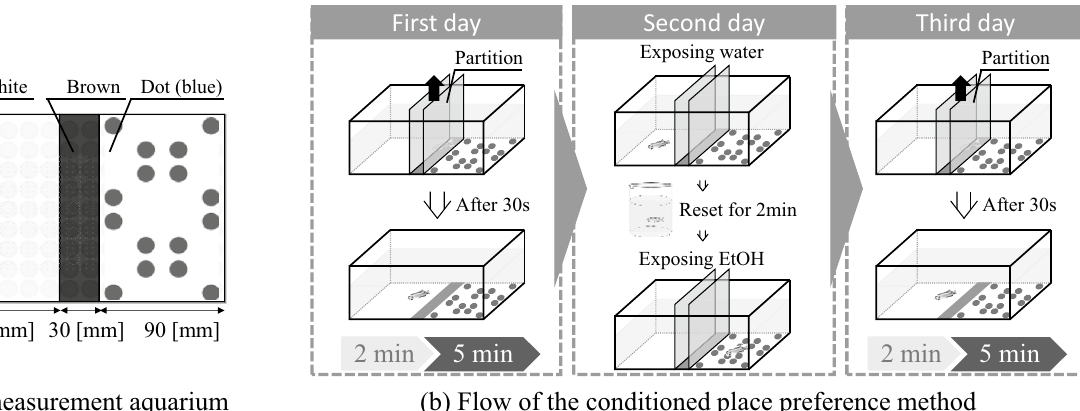
Figure 3. Experimental protocol for exposure of fish to ethanol. The experimental environment was configured based on the literature 4 . ( a ) Measurement aquarium, divided into three sections using gauze with different colour patterns. ( b ) Flow chart of the place preference conditioning protocol. The initial place preference is measured on the first day. The fish is conditioned on the second day to induce a place preference. The ventilatory signals and motion on the first and third day were analysed and